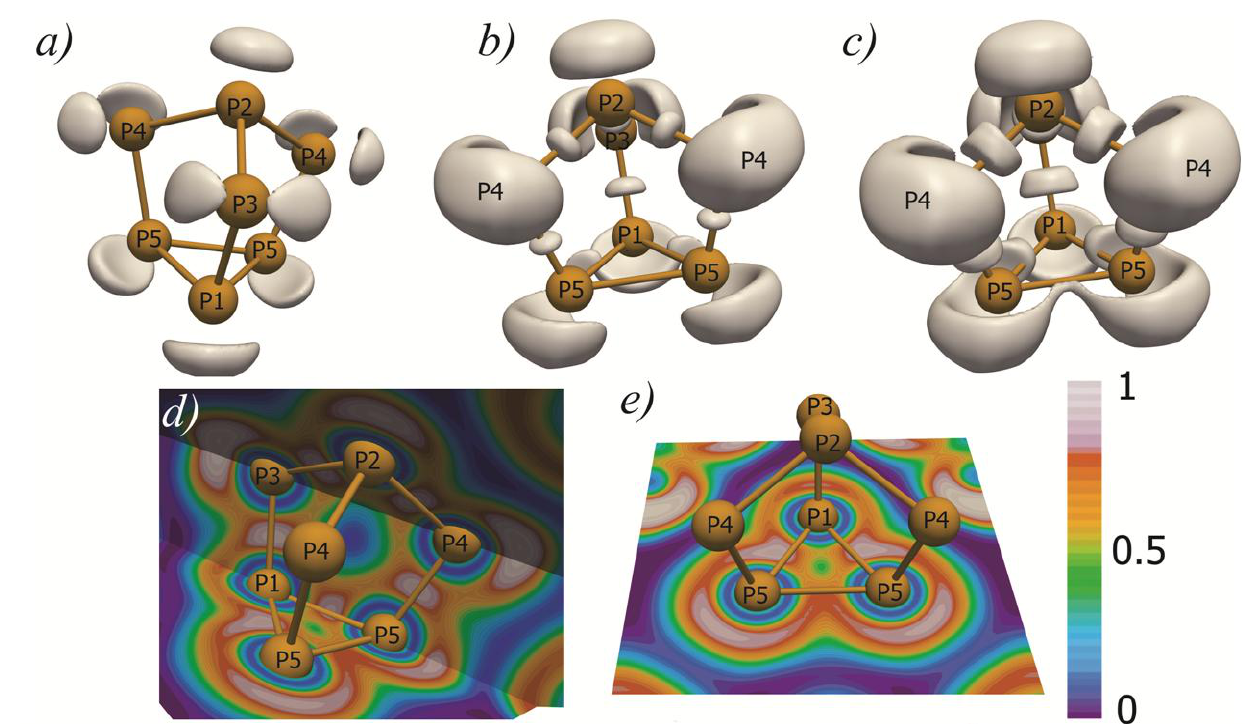
Figure 6. Top: 3D isosurfaces of electron localization function ( η ) for the P 73− phosphorus cluster in Ba P I, ( a ) η = 0.91; ( b ) η = 0.83; ( c ) η = 0.765. Bottom: coloring of the electron 2 7 localization function distribution for the slices of the phosphorus cluster in Ba The color bar is given in the right bottom